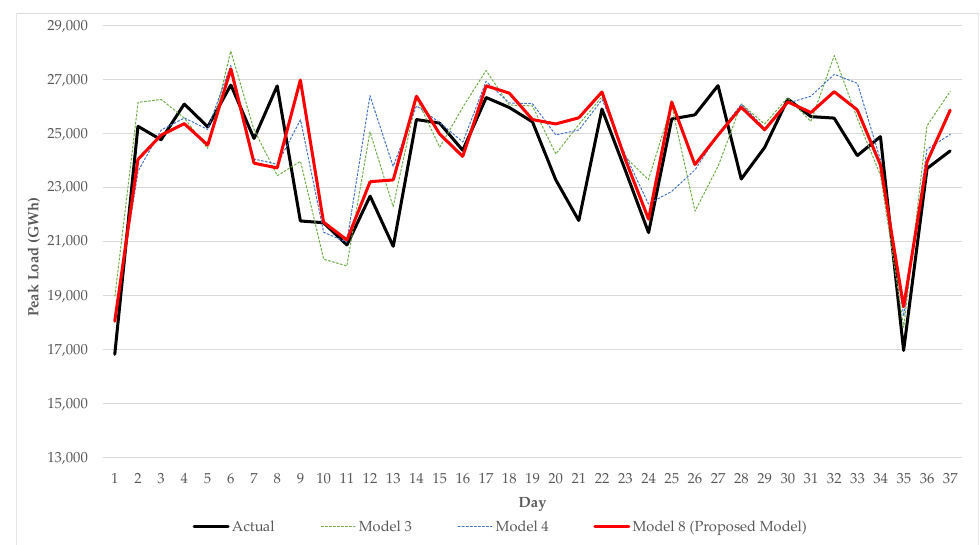
Figure 11. The comparison of the top three models measuring test performance.